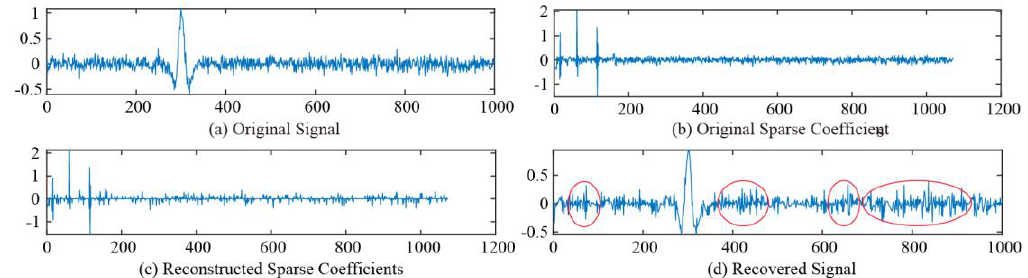
Figure 2. Ricker waveform reconstructed by compressed sensing. ( a ) Original signal, ( b ) original sparse coefficients, ( c ) reconstructed sparse coefficients, and ( d ) recovered signal.